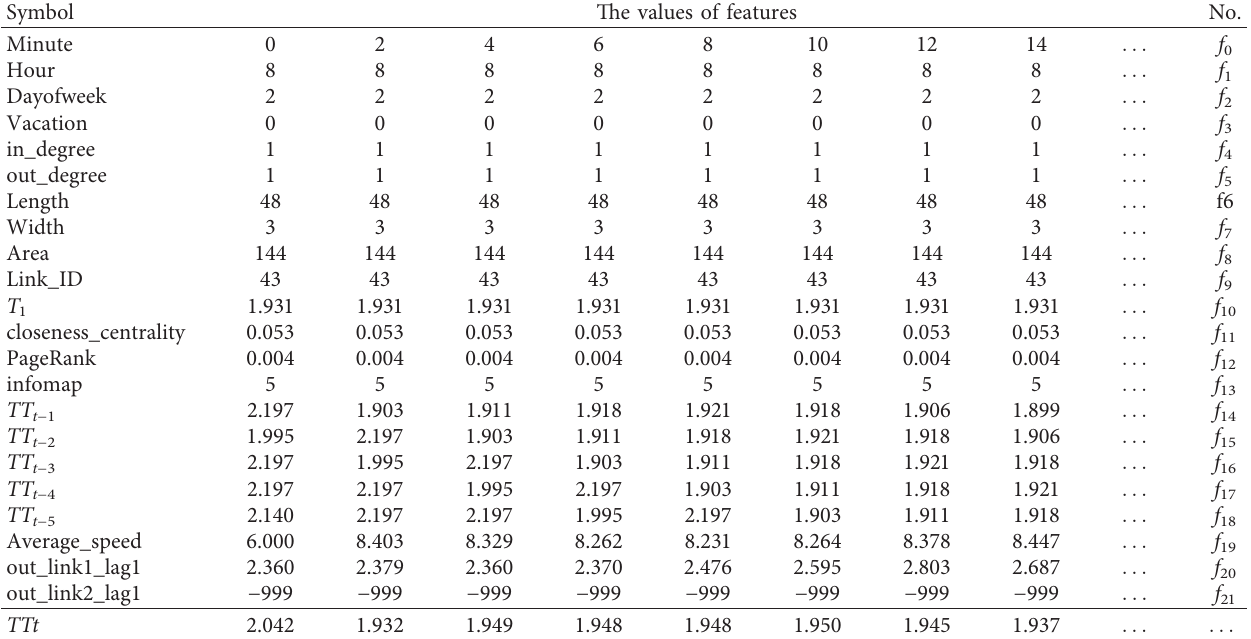
Table 4: XGBoost model input and output.